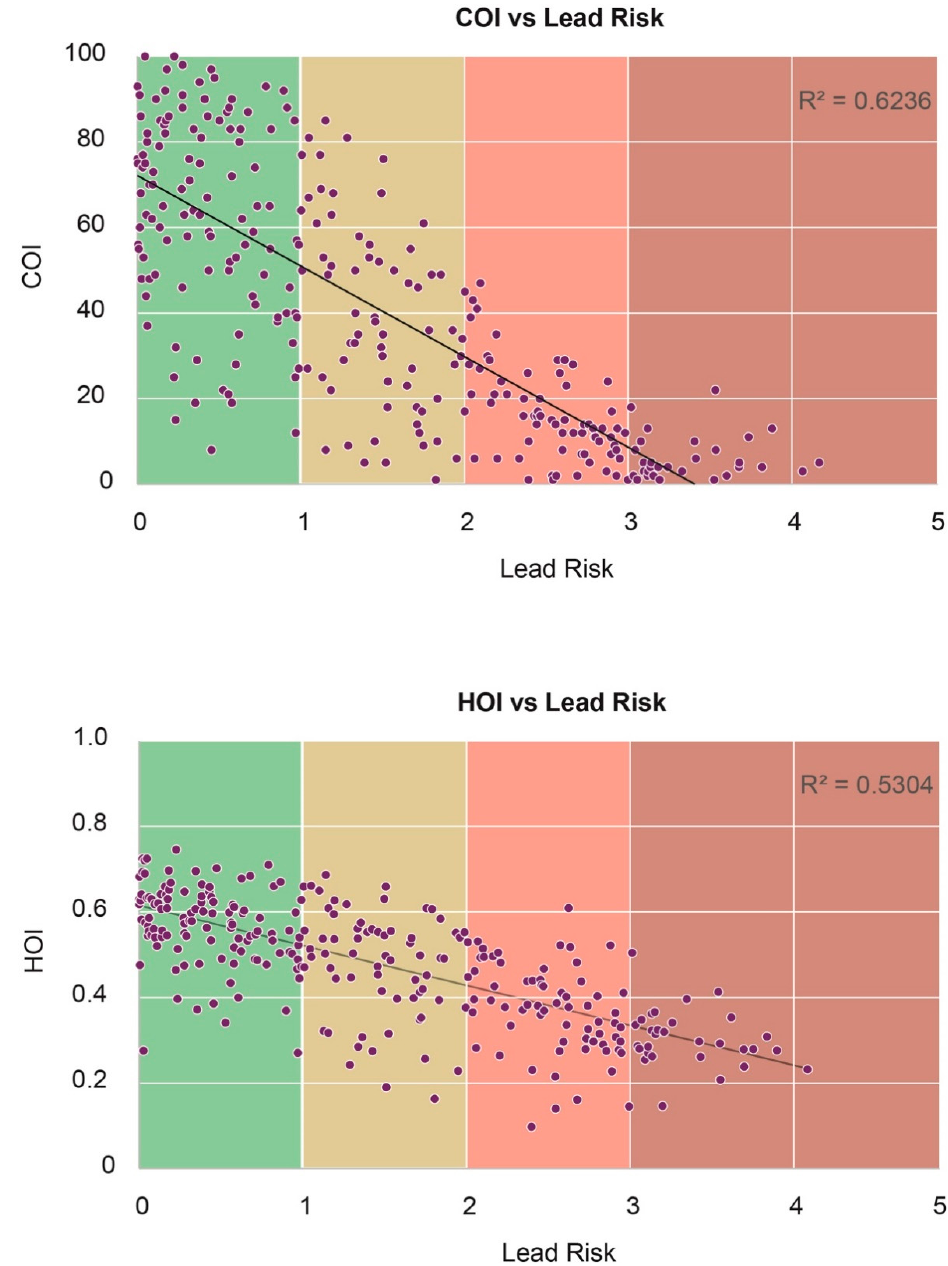
Figure 10. Lead risk compared to Child Opportunity Index 2.0 (COI) and Health Opportunity Index (HOI) score.